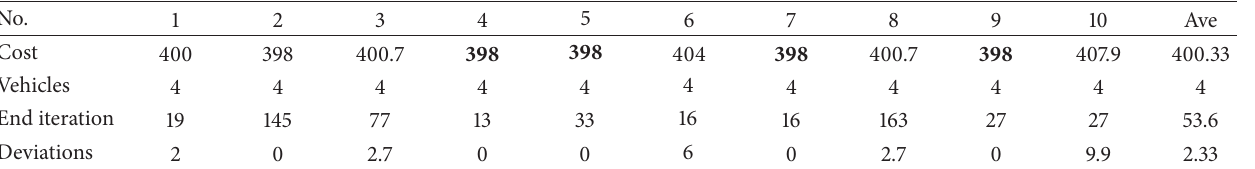
Table 6: The results of DNA-ant colony algorithm (top or good air pollution level).